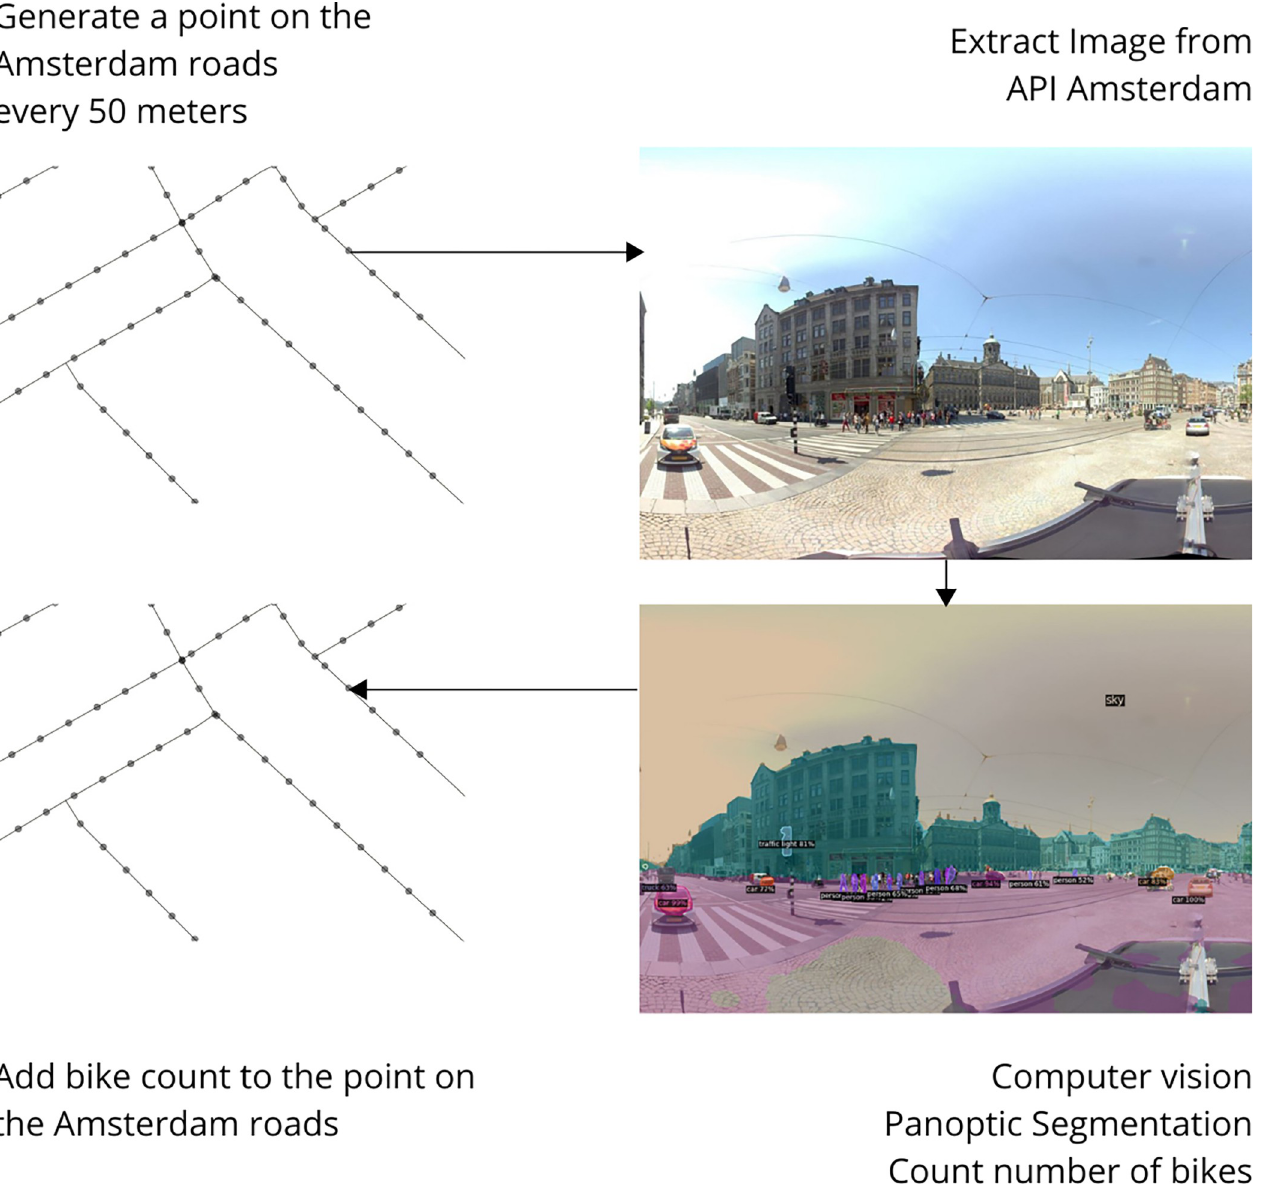
Fig 6. Schematic of the panoramic image processing. Original images: Municipality of Amsterdam. Each image, connected to one of the ~82,000 points in Amsterdam, was subsequently ana- lyzed using the selected pre-trained panoptic segmentation model. This process results in points with an attribute indicating the number of bikes in each image (Fig 6). These points were subsequently loaded into QGIS and aggregated to the neighborhood level, by counting the number of points in the neighborhood polygons with a weight factor equal to the number of bikes visible in the images. After this process, the number of bikes per neighborhood was divided over the number of points per polygon, resulting in the average number of bikes in each image per neighborhood.